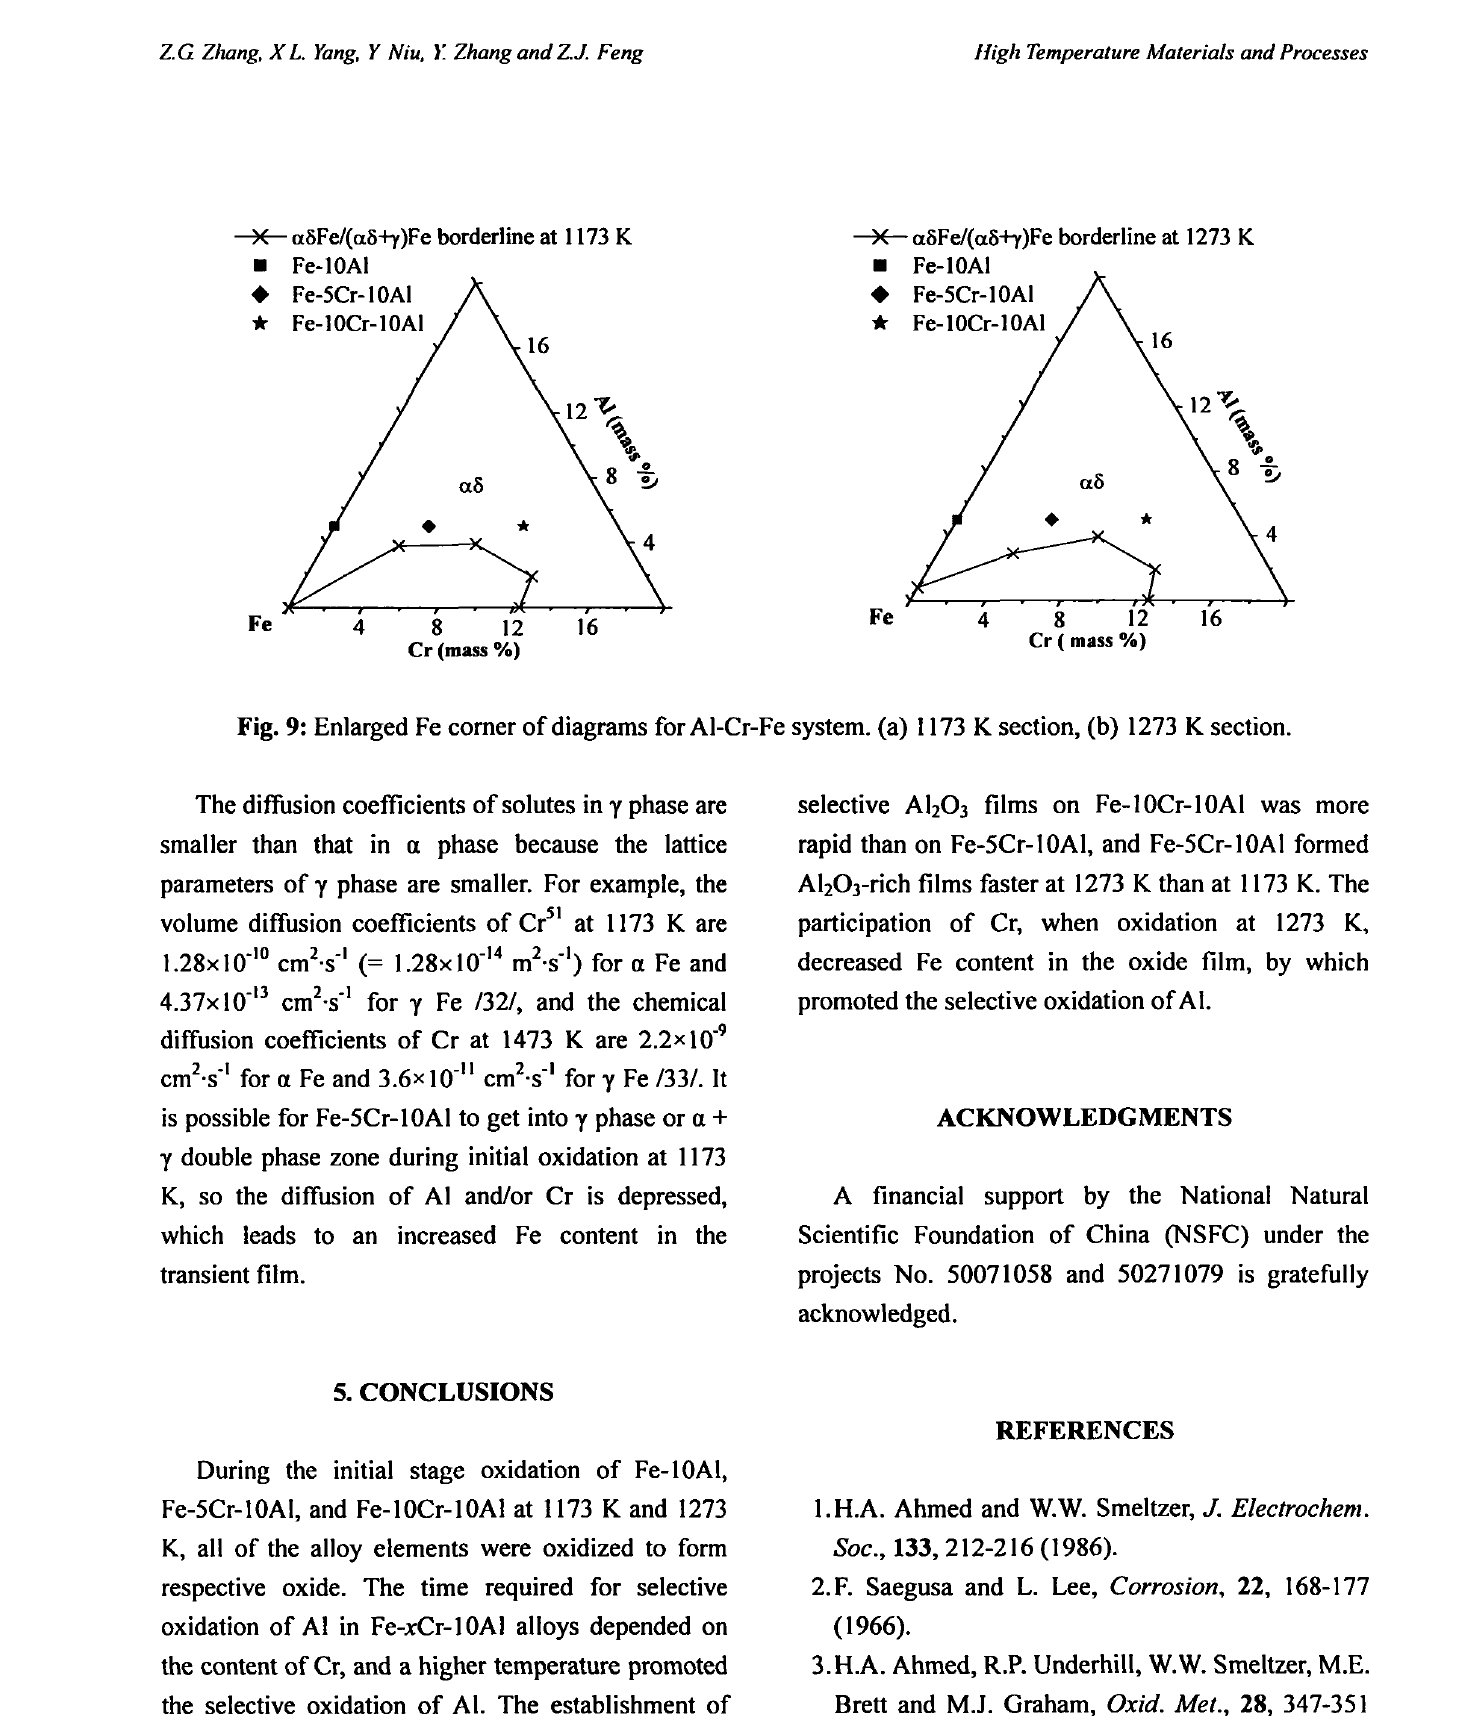
Fig. 9: Enlarged Fe corner of diagrams for Al-Cr-Fe system, (a) 1173 Κ section, (b) 1273 Κ